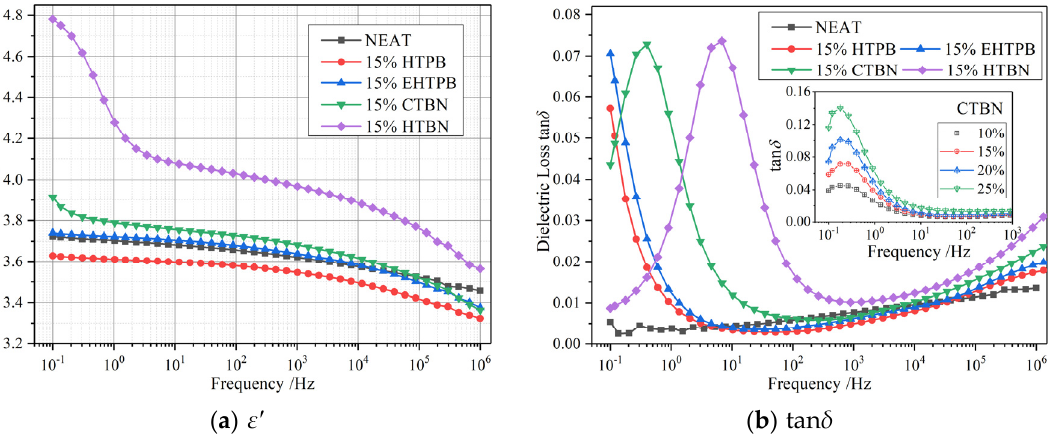
Figure 7. Frequency spectrum of epoxy resin toughened by four kinds of liquid rubber at 15% liquid rubber content (25 °C). ( a ) ε ′ ; ( b ) tan δ . ε ′ increases with the increase of the polarity of liquid rubber. rubber content (25 ◦ C). ( a ) ε (cid:48) ; ( b ) tan δ . ε (cid:48) increases with the increase of the polarity of liquid rubber. Interfacial polarizations appear in the curves of tan δ . Interfacial polarizations appear in the curves of tan δ